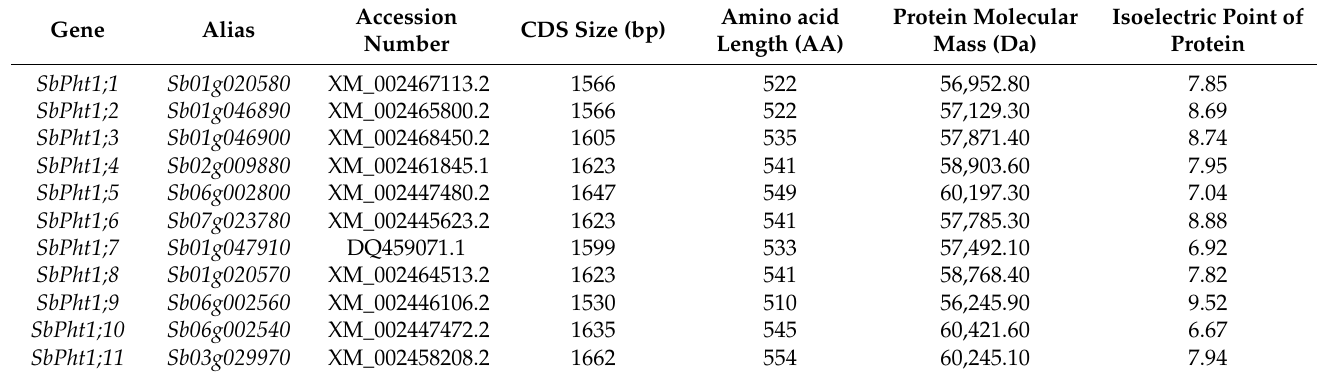
Table 1. Pht1 gene family in sorghum.